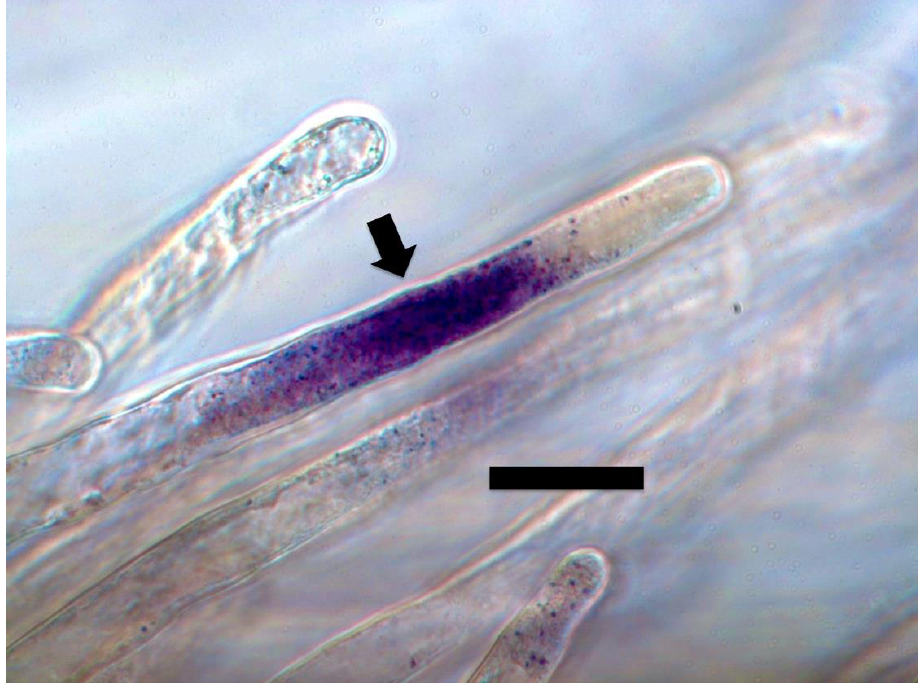
Figure 6. Tall fescue seedling root hair stained with 0.1% nitro blue tetrazolium showing superox- ide (purple color) around bacterial protoplasts in the hair (arrow; bar = 20 µm).